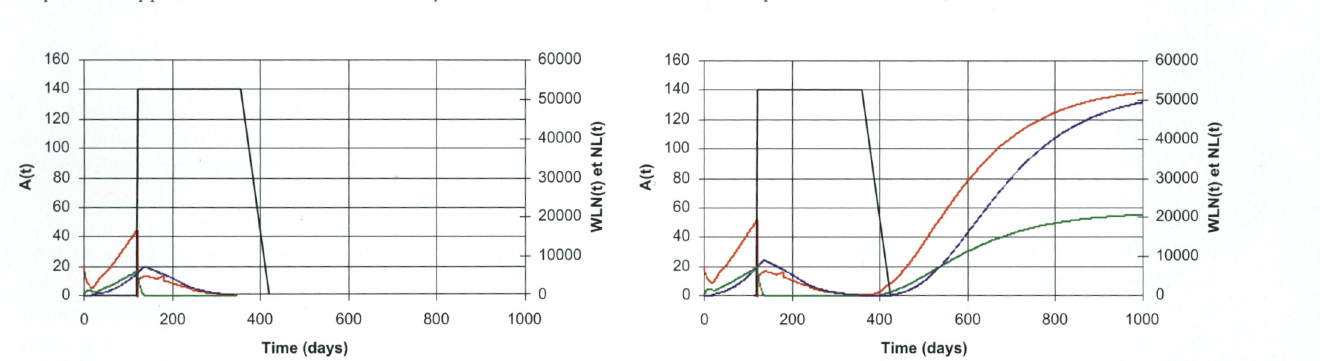
Fig. 21. - Dynamics of model with regular outdoor movements of host animal and in-flow of fleas: use of the association persistent insecticide + spot-on IGR at D 120, D 180 and D 240.